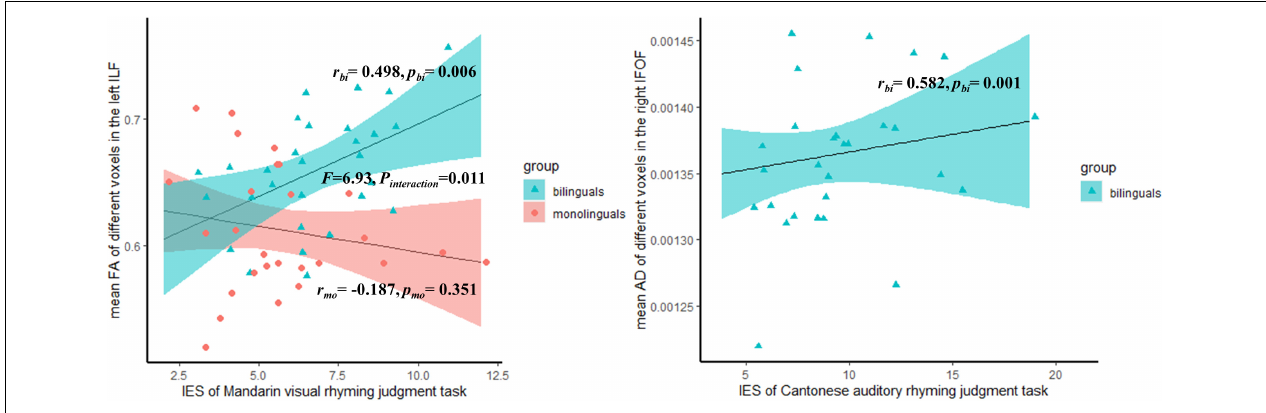
FIGURE 3 | The significant correlation between the mean different DTI indices of significant voxels in the tracts and behavioral measures, within the